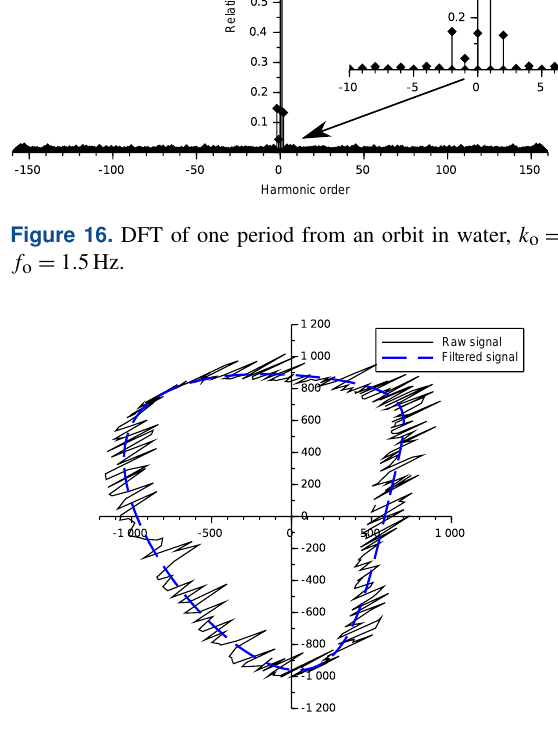
Figure 17. Filtered orbit in water, k o = 0 . 02, f o = 1 .